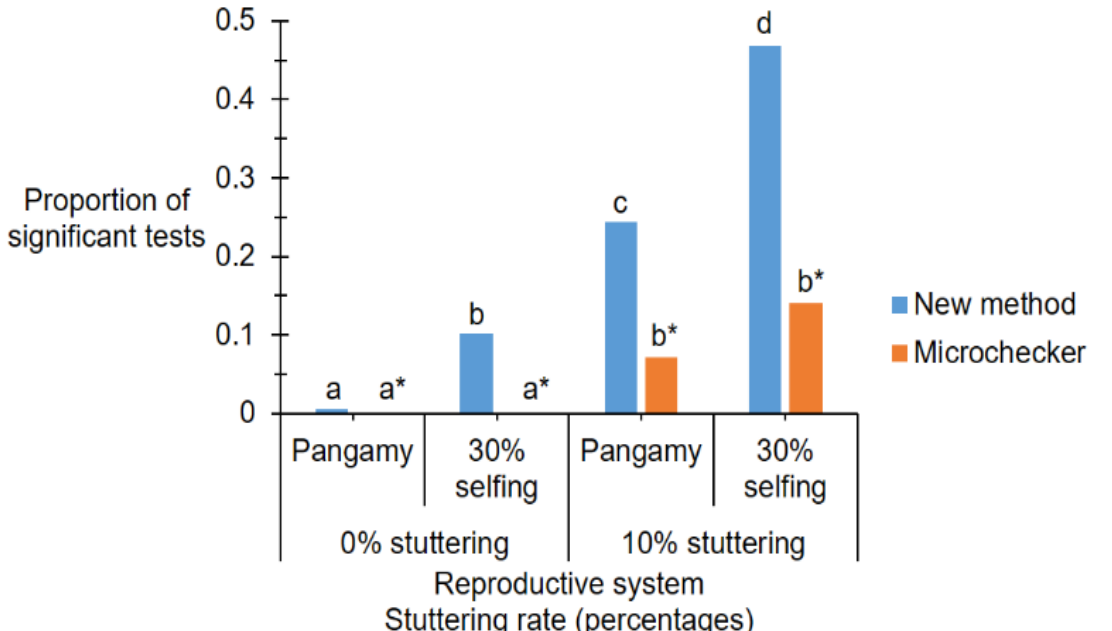
Figure 2: Statistical comparisons, within each kind of simulation, between MicroChecker and the alternative method (New method), between reproductive systems and, within the alternative method, between dataset without or with 10% stuttering to detect stuttering under the null hypothesis with no stuttering or with 10% of alleles affected, and for different system of mating (dioecious pangamy or 30% of selfing). Significant differences (all p -values<0.0001) are indicated by different letters and correspond to Fisher exact test comparing number of significant (S) and not significant (NS) tests (before Benjamini and Hochberg correction) between the two methods. Asterisks stand for comparisons, within a single parameter set, between Microchecker and the alternative method. To this respect, the p -value within dioecious pangamic (Pangamy) populations with 0% selfing was p -value=0.2494. As can be seen from Figure 2, selfing significantly increased stuttering detection, even under H0, where it significantly appeared above the 5% threshold ( p